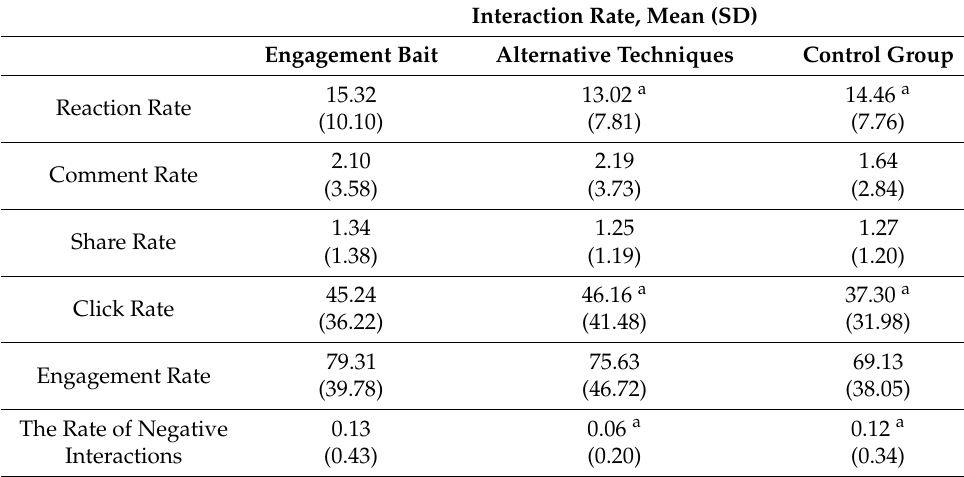
Table 3. The mean and the SD of interaction rate by engagement bait, alternative techniques and the control